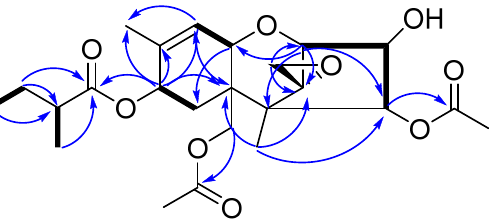
Figure 2. Key 1 H- 1 H COSY (black solid line) and HMBC (blue single arrow) correlations of 1 .